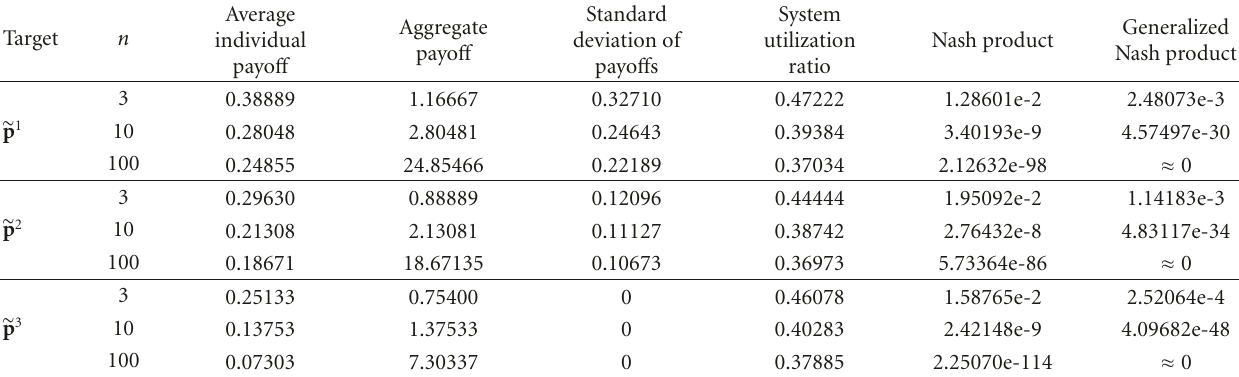
Table 2: Average individual payo ff s, aggregate payo ff s, standard deviations of individual payo ff s, system utilization ratios, Nash products, and generalized Nash products with heterogeneous